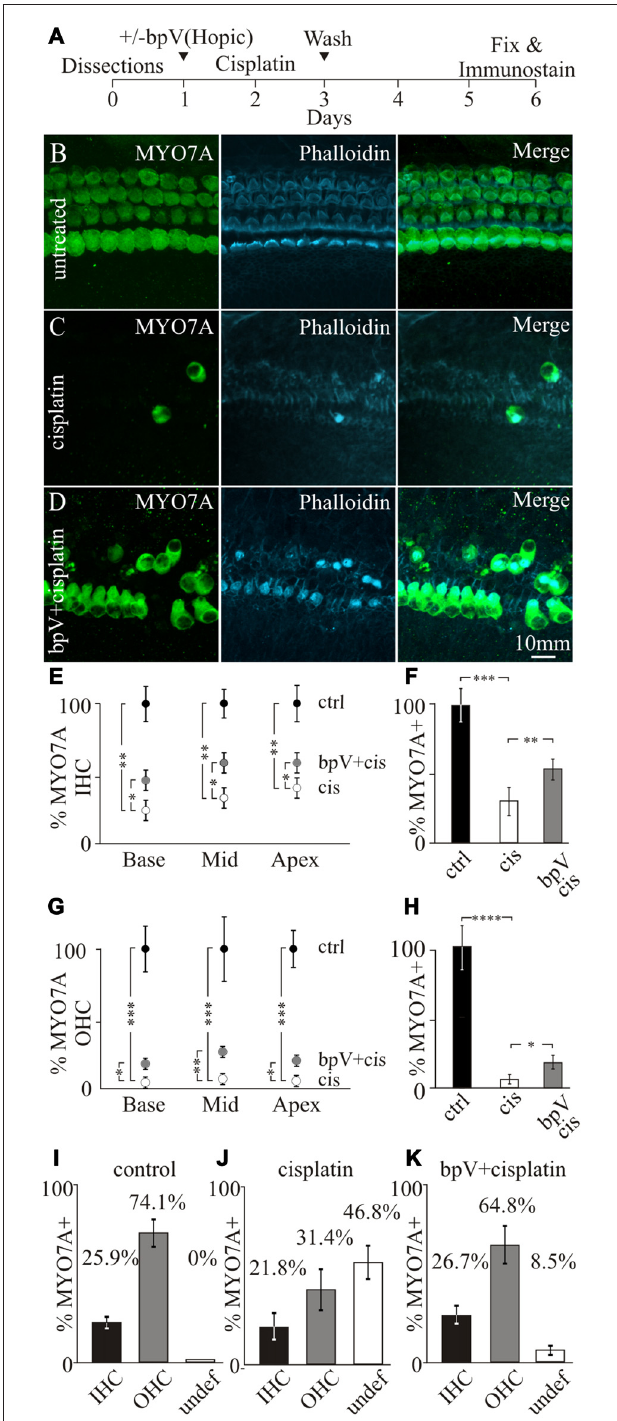
FIGURE 3 | Effects of bpV(HOpic) on hair cell survival after cisplatin damage. (A) Timeline of cochlear explant cultures describing the addition of 10 µ M bpV(HOpic) 1 day before 10 µ M cisplatin treatment and harvesting of explants for immunostaining. Immunofluorescence of MYO7A, phalloidin and merged images from (B) control cochlear explant ( n = 4), (C) cochlear explant treated with cisplatin ( n = 4) and (D) cochlear explant pretreated